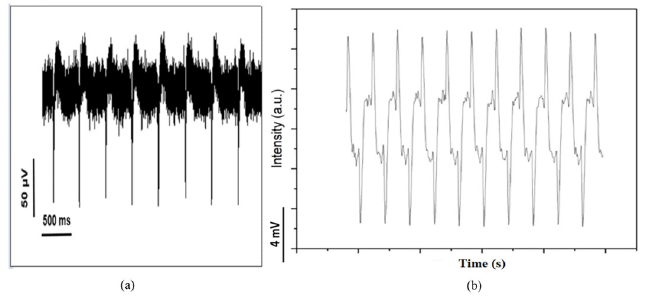
Fig 11. (a). Signal recorded by electrophysiology method. (b). Signal recorded by the plasmonic